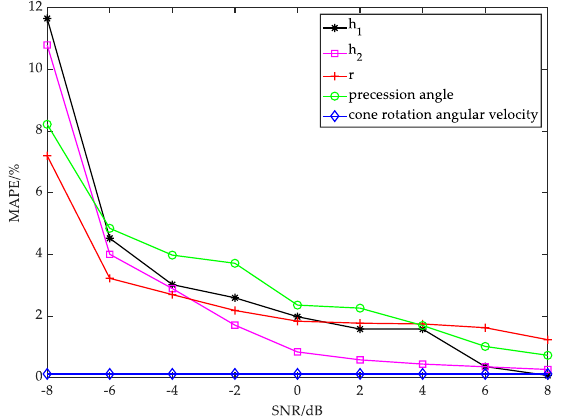
Figure 11. MARE of different target parameters. (LOS = 30 ∘ ).